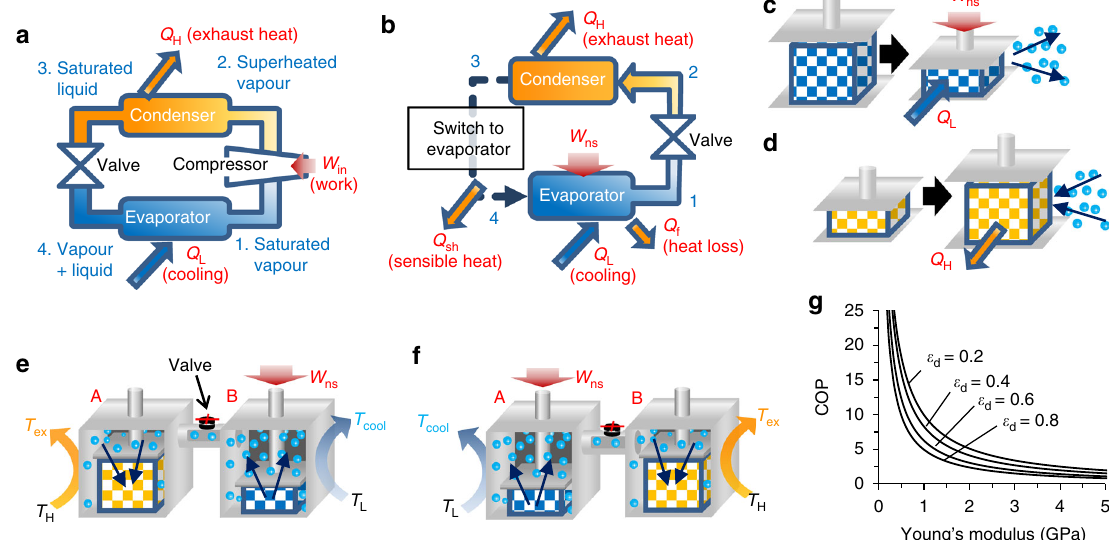
Fig. 6 Comparison of the two refrigeration principles. a Schematic of the Refrigeration based on the Bulk Phase Transition (RBPT). The refrigerant undergoes four different phase transformations described by the numbers 1 − 4. Saturated vapour (1) is compressed with the external work ( W in ) to be superheated vapour (2). 2 turns into saturated liquid (3) at the condenser by emission of exhaust heat ( Q H ) to outside. 3 is expanded by the valve to be the mixture of vapour and liquid (4), and 4 is turned into 1 at the evaporator which is equipped with a heat-exchanger connected to a target room. The evaporator draws the heat ( Q L ) from the target room. b Schematic of the Refrigeration based on the Mechanical-force-induced Phase-Transition of Adsorbate (RMPTA). Evaporator and condenser are equipped with nanosponges for phase transition and heat exchangers. 1 in the evaporator moved to the condenser to be 2. The valve is open only when the vapour pressure in the condenser is lower than that in the evaporator. When nanosponge in the condenser fully adsorbs refrigerant, the condenser is switched to the evaporator, and vice versa. The RMPTA system emits Q H , sensible heat ( Q sh ), and heat loss ( Q f ), while Q L is drawn from the target room for cooling. c , d Illustrations of the c refrigerant desorption induced by the external work W ns and d refrigerant adsorption caused by the free expansion of the nanosponge. e , f A refrigeration system consisting of the two chambers (A and B) that are alternately compressed and released to serve as the evaporator and condenser, respectively. In c – f , blue spheres represent refrigerant vapour, while amber arrows indicate the moving directions of the vapour: desorption in c , B of e and A of f , adsorption in d, A of e , and B of f . g Approximate relations between the COP and Young ’ s modulus of the nanosponge, which were obtained at various nanosponge strains ε d calculated using Eq. (35) when pore diameter ( d p ) is 1.2 nm (the value in ZTC). Decreasing ε d increases the magnitude of COP and overall nanosponge volume, making the entire system bulkier